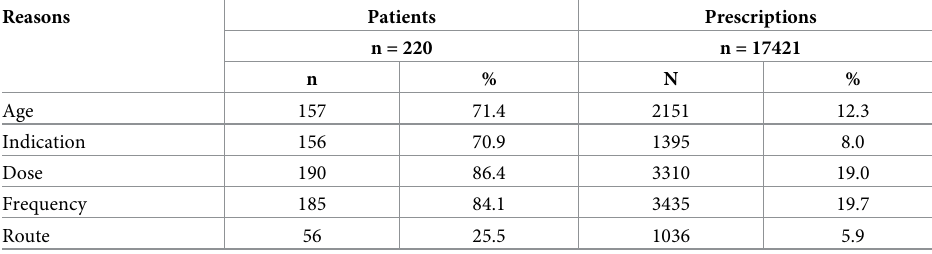
Table 3. Reasons for the classification of off-label drug use in newborns in an intensive care unit.